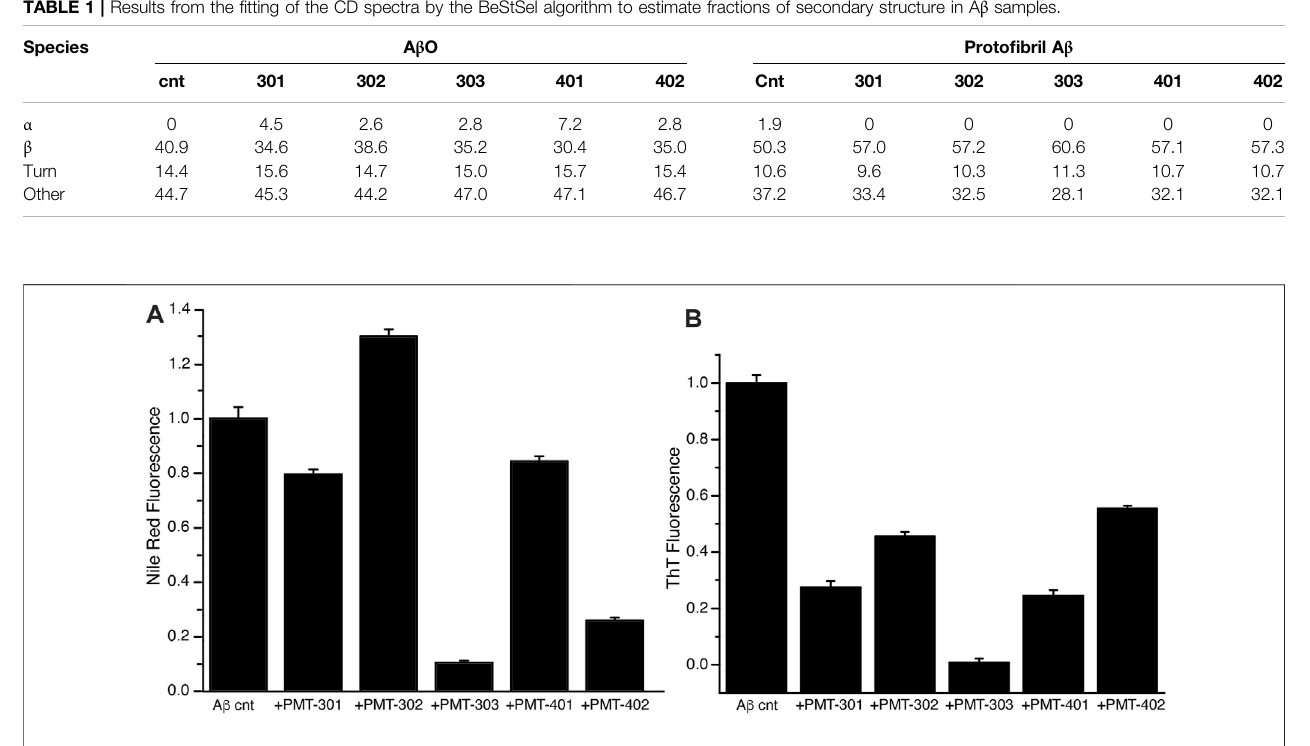
FIGURE 6 | PAL effect on A β O-associated dyes. (A) Nile Red fl uorescence intensity with or without designated PAL addition after 5-h incubation. (B) ThT fl uorescence intensity at t = 24 h was measured for A β alone or A β + PAL compounds. All samples were run in triplicates.